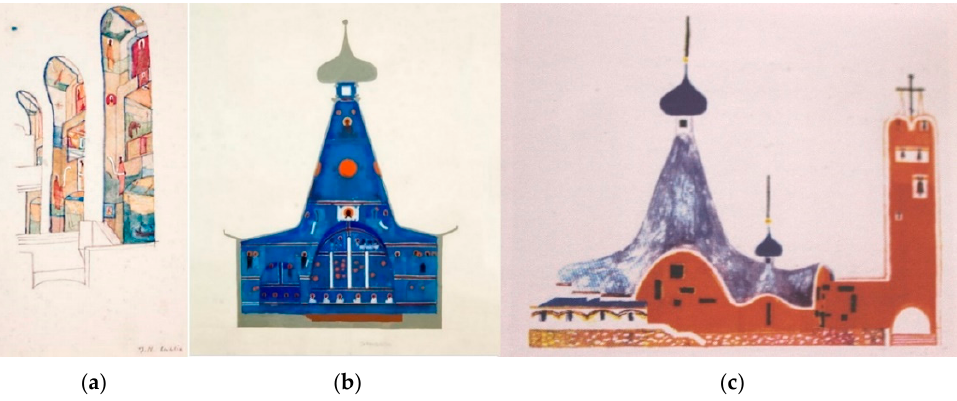
Figure 6. Jerzy Nowosielski: ( a ) conceptual sketch of the polychrome of the church at the Catholic University of Lublin, 1962. Photography by M. Gardulski/Galeria Starmach. Reproduced with permission. ( b ) The original color scheme of the Orthodox church in Hajnówka, 1972—interior ( c ) facade. Photography by M. Gardulski/Galeria Starmach. Reproduced with permission.